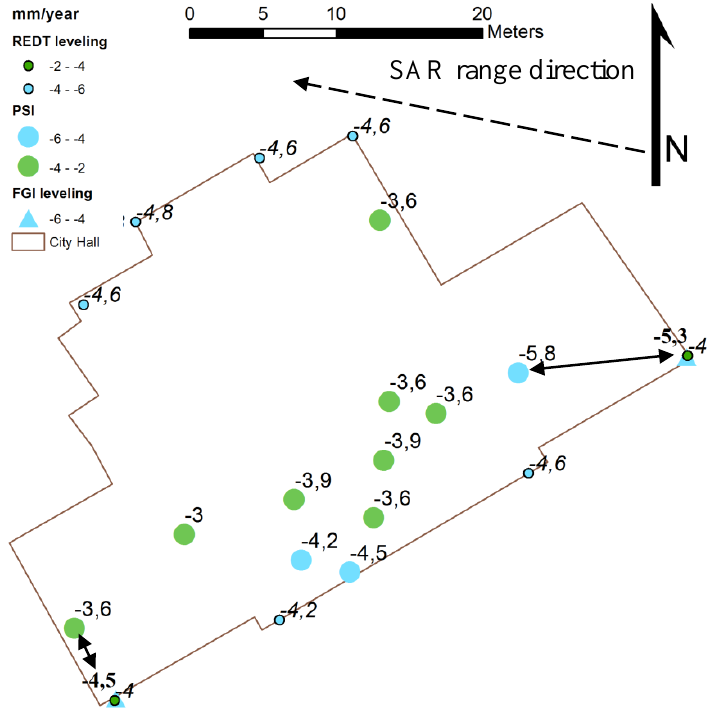
Figure 5. 11 PS, eight REDT and two FGI leveling benchmarks and their vertical deformation rates in Town Hall. Selection of the closest PS for two FGI benchmarks is shown with arrows. For mean annual PSI rate all 11 PS were